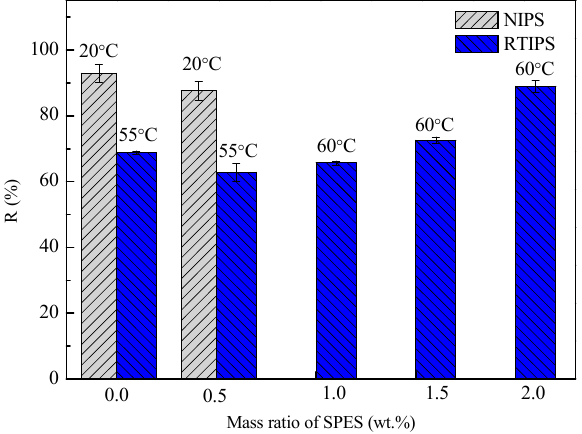
Figure 6. Pure water permeation flux of the prepared PES hollow fiber membranes.